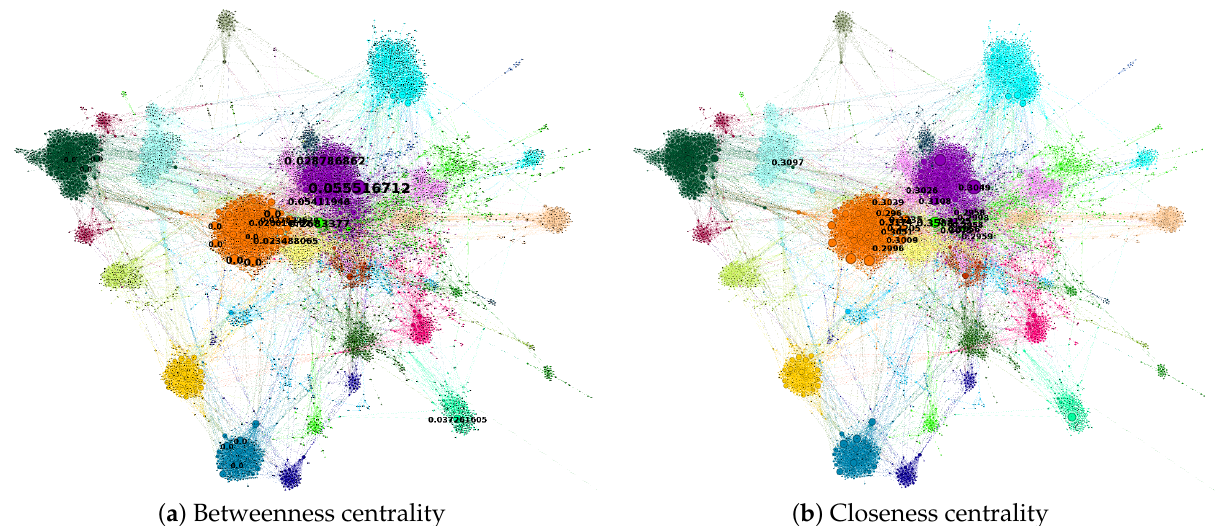
Figure 6. Politicians: Comparison of centrality metrics and hub-dominance of communities. Table 7. Karate network: Centrality scores of hub-dominant nodes—rank in paranthesis.